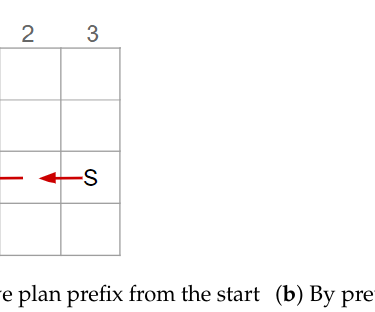
Figure 1. In this grid-based navigation example, a human can move horizontally and vertically. There are multiple optimal plans to each of the goals, but for readability only a single plan to each goal is shown (indicated with arrows). On the left figure, the plans with the longest non-distinctive prefix are displayed. Reproduced from prior work